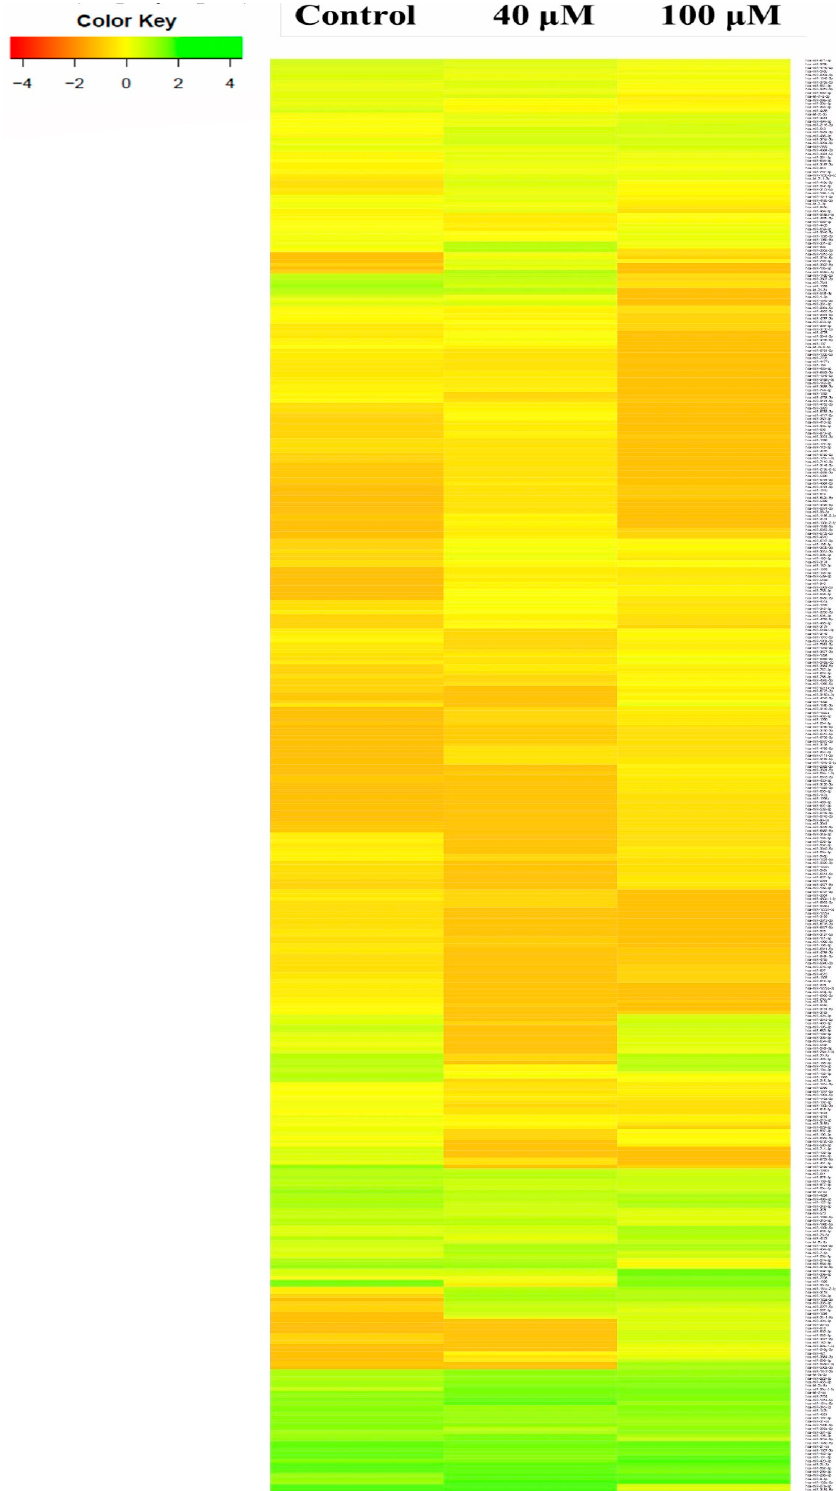
Figure 5. The expression profiles of known microRNAs in the untreated control, 40 μ M, and 100 μ M EGCG treatments. Color key- red: up-regulation, green: down-regulation and yellow: neutral expression.